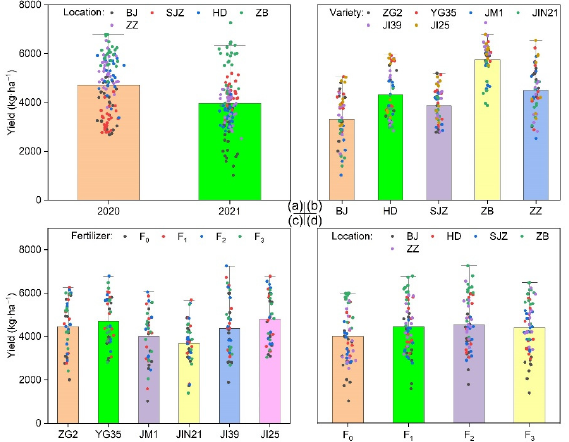
Figure 3. Foxtail yield variation among year ( a ), locations ( b ), varieties ( c ), and fertilizer ( d ) in the year 2020–2021 cropping seasons in China. The histogram represents the average yield, the scatter represents the yield data of all samples, and the median ± interquartile range (IQR) with bars represents the range within 1.5 IQR. The scatter of different colors represents different treatment methods (such as location, variety, and fertilization).